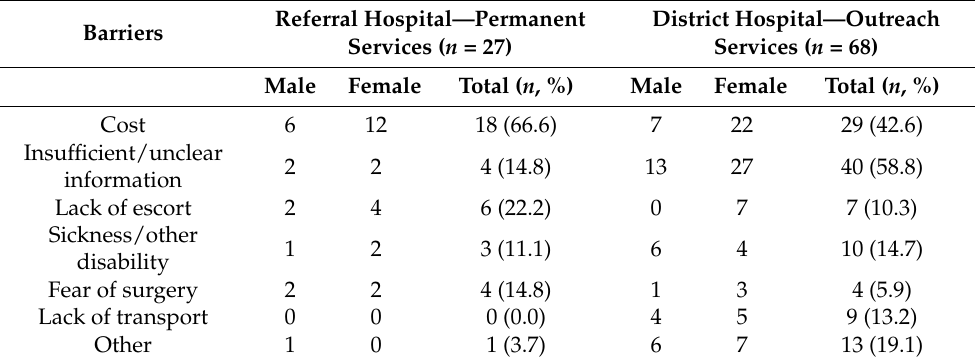
Table 3. Barriers to attending a cataract surgical appointment in Rwanda, May–July 2019 ( n =